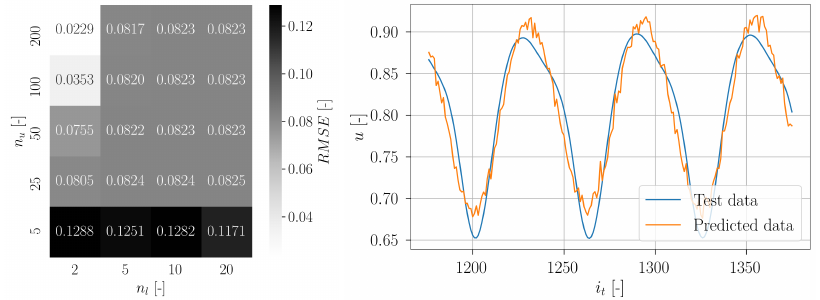
Figure 14. Heatmap and timeseries reconstruction for setup 1 of the cylinder case.